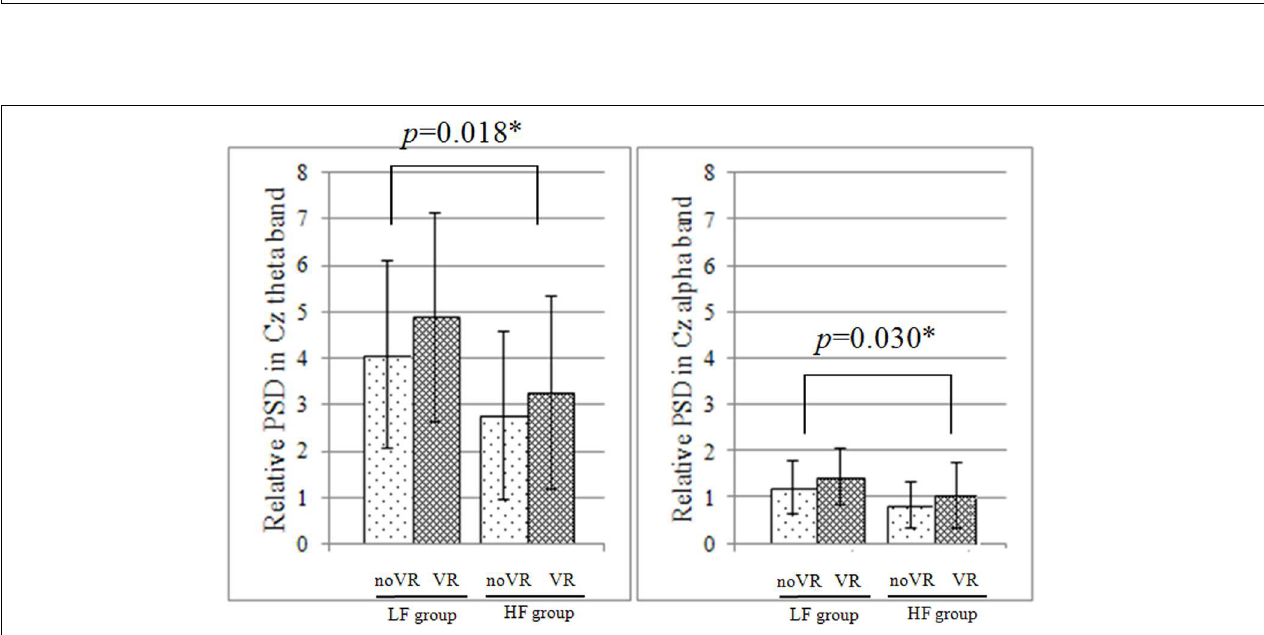
FIGURE 2 | Posture-related cortex regions. The electroencephalography signals at the Fz, Cz, Pz, and Oz sites denote the posture-related cortical regions, and the relative power spectrum density (PSD) was calculated in order to describe the cortical modulations during motor control.